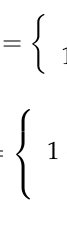
Figure 2. Elastic–brittle damage constitutive law of the micro element.